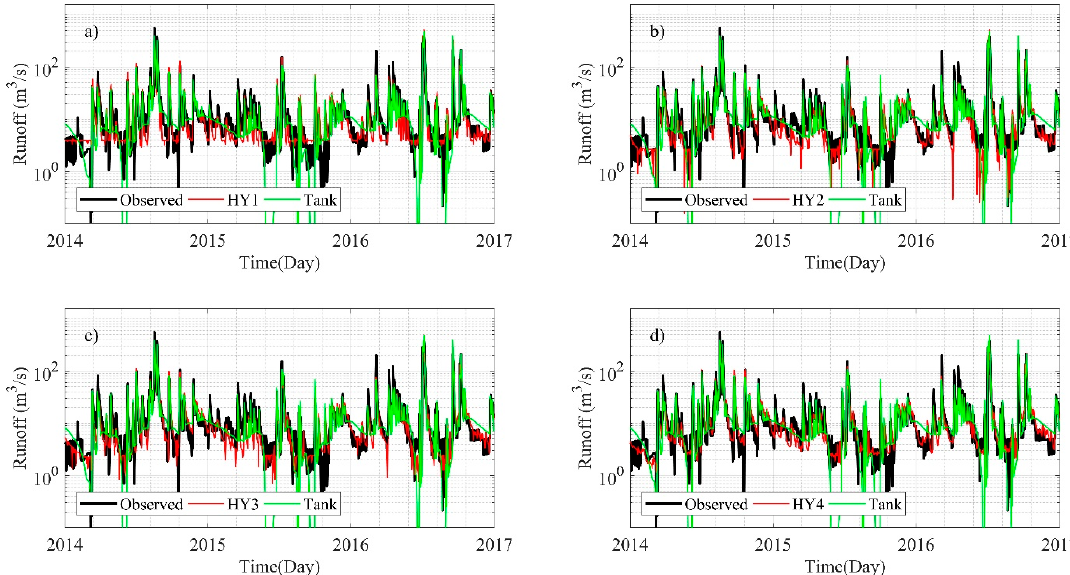
Figure 13. Simulated runoff comparison between the tank model and four different Tank-LSSVM models (HY1, HY2, HY3, and HY4). Direct observation runoff data from 2014 to 2016 are also included.